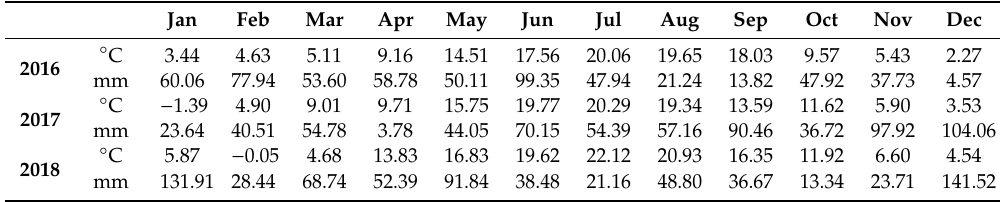
Table 2. Monthly average temperature ( ◦ C) and precipitation (mm) for the years 2016, 2017, and 2018. Jan Feb Mar Apr May